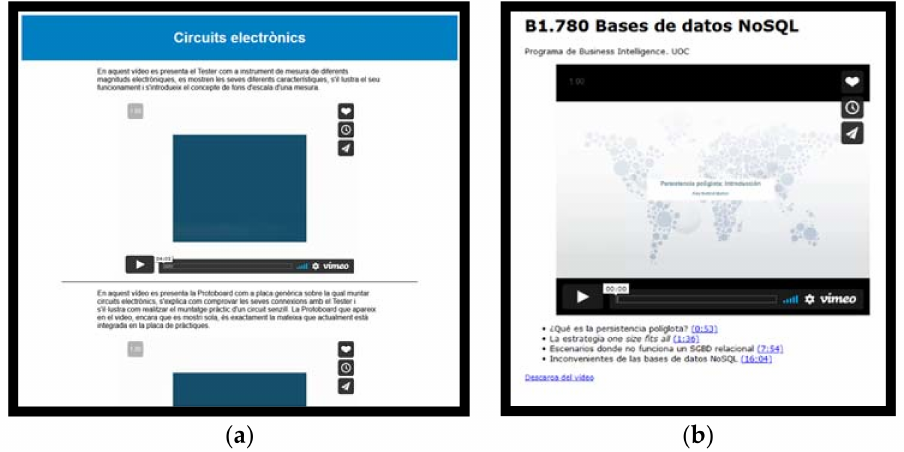
Figure 1. Two examples of the presentations of videos in the virtual classroom. All videos in a course are presented in a homogenous way, but differences in presentation exist among different courses. In most cases, the video or videos are embedded in the webpage with no additional features, see leftmost figure ( a ). In some cases, a table of contents is provided, with active links that take the user to the corresponding moment in the video, see rightmost figure ( b